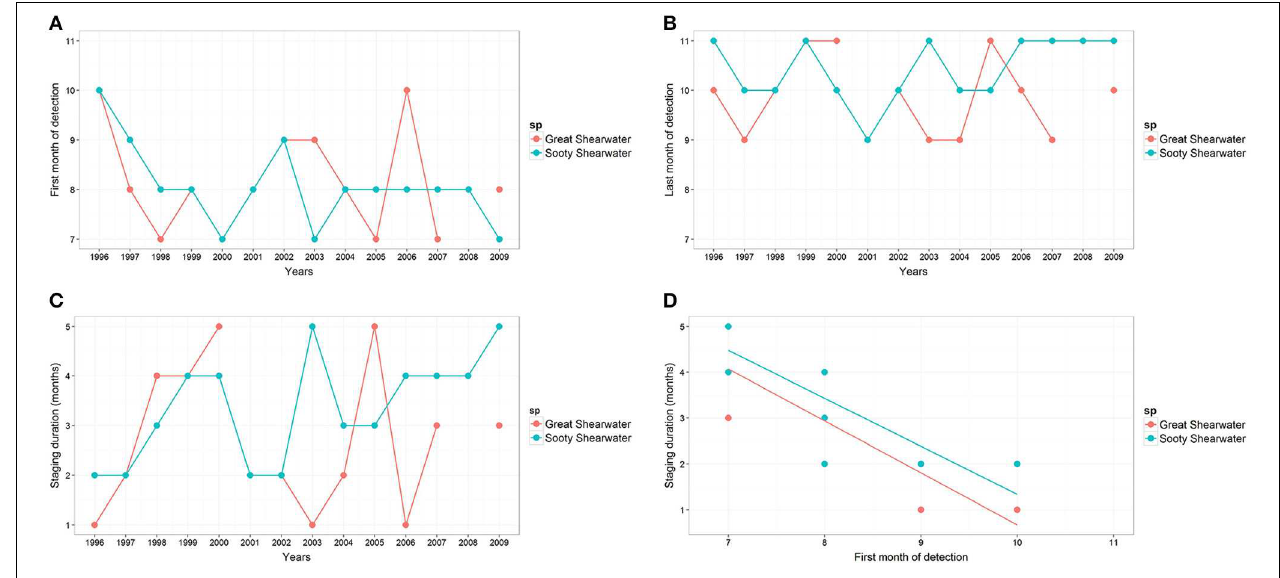
relationship between both of them. GRSH, great shearwater; SOSH, sooty shearwater. Note that GRSHs were not detected in 2001 and